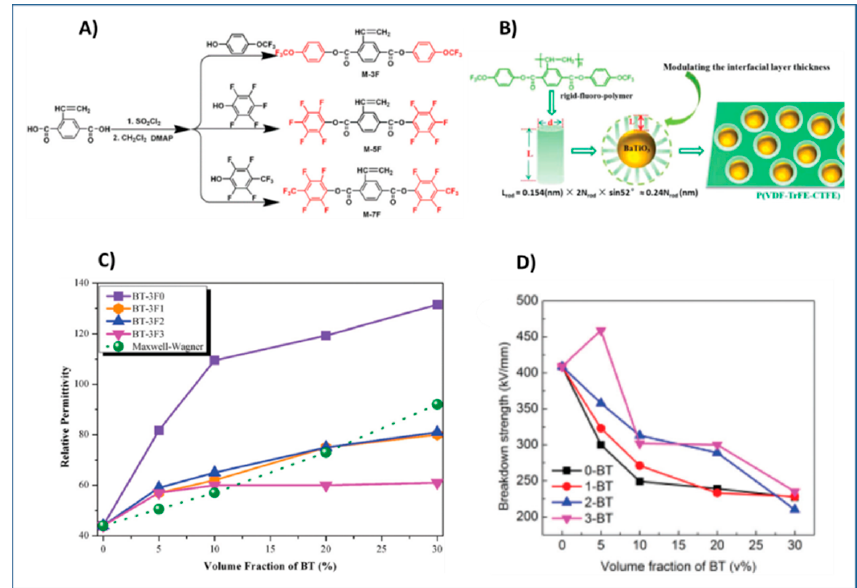
Figure 15. ( A ) Synthetic route for formation of TFMPCS monomer ( B ) schematic illustration of rigid-fluoropolymer@ BaTiO 3 /PVDF-TrFE-CTFE dielectric nanocomposite films ( C ) The permittivity of PVDF-TrFE-CTFE nanocomposites films with BT-3F0, BT-3F1, BT-3F2, and BT-3F3 at 1 kHz. ( D ) Variation of characteristic breakdown strength from Weibull distribution for samples with various volume fractions of fillers. Reproduced with permission from Ref. [130].